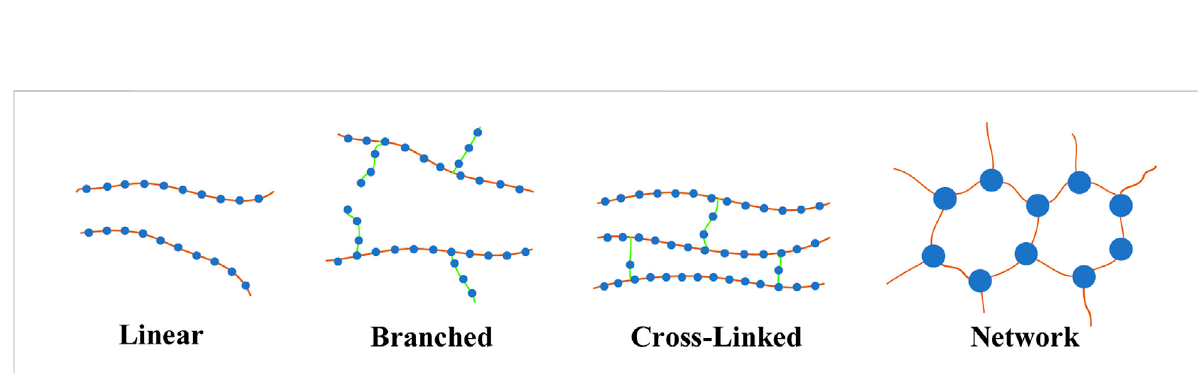
Diagrams of linear, branched, crosslinked, and networked polymer